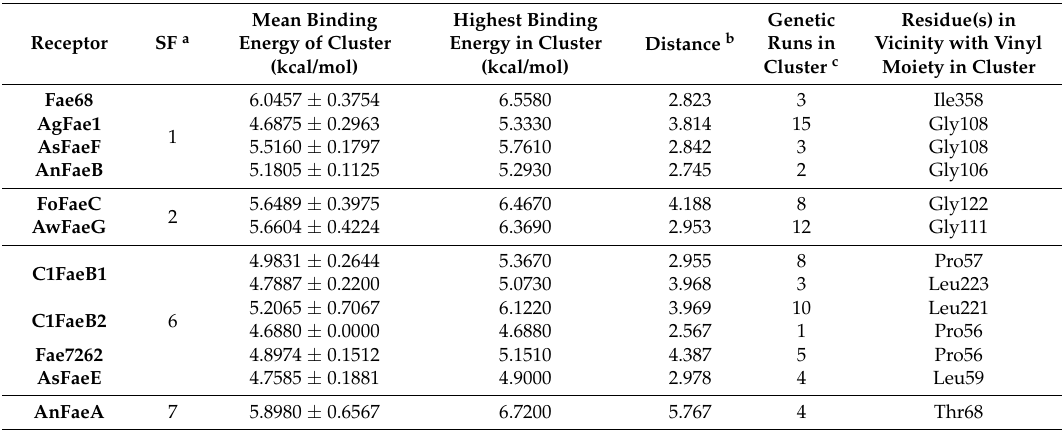
Table 5. Results of docking of ligands on the predicted structure of selected fungal FAEs (SF1–3 and SF6–7) at a catalytic